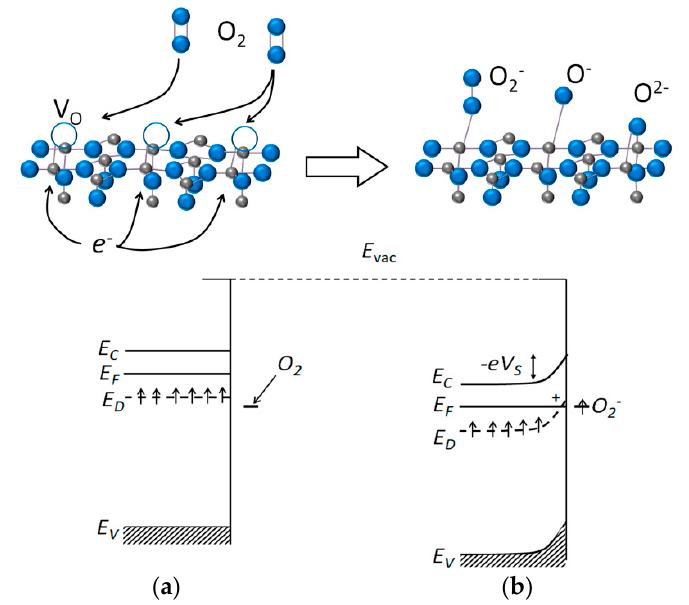
Figure 1. Schematic of representation ( top ) of the surface of MOS possessing oxygen vacancies (V O ) before ( a ) and after oxygen ionosorption ( b ); and the corresponding modulation of band energy levels ( bottom ): vacuum level ( E vac ), conduction band bottom ( E C ), Fermi level ( E F ), donor states level ( E D ), valence band top ( E V ), potential energy surface barrier ( − eV S ).